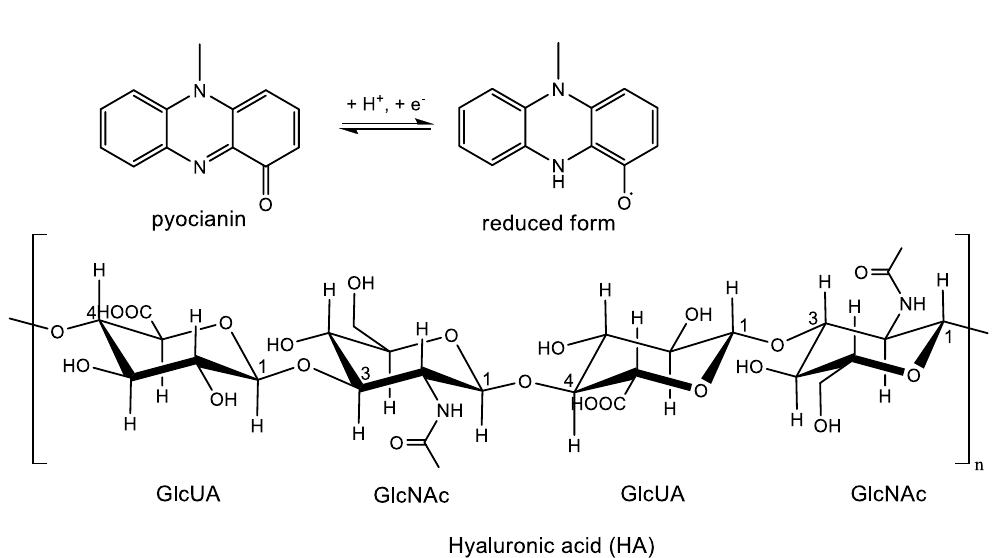
Scheme 1. Structures of the pyocyanin and its reduced form and of the anionic polyelectrolyte hyaluronic acid